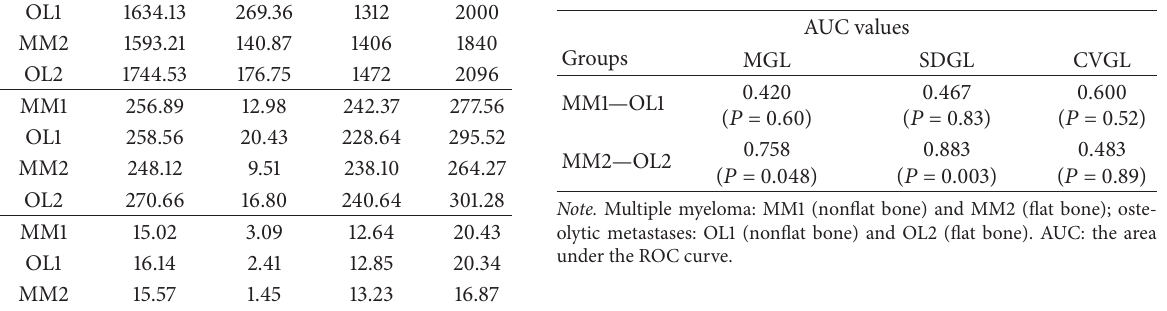
Table1:Descriptivestatisticsforthethreeparametersstudied:mean (MGL), standard deviation (SDGL), and coefficient of variation (CVGL) of gray level. Groups